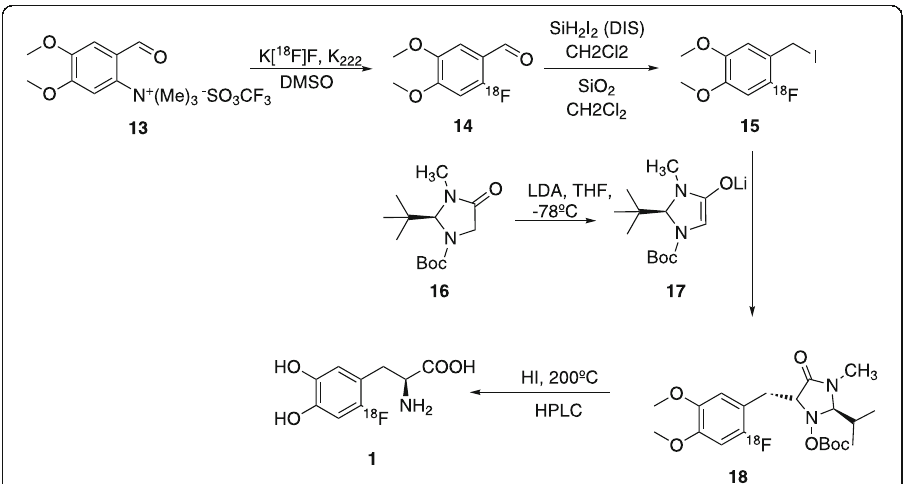
Fig. 5 Synthesis of 6-[ 18 F]FDOPA 1 starting from aryltrimethylammonium precursor, using chiral auxiliaries